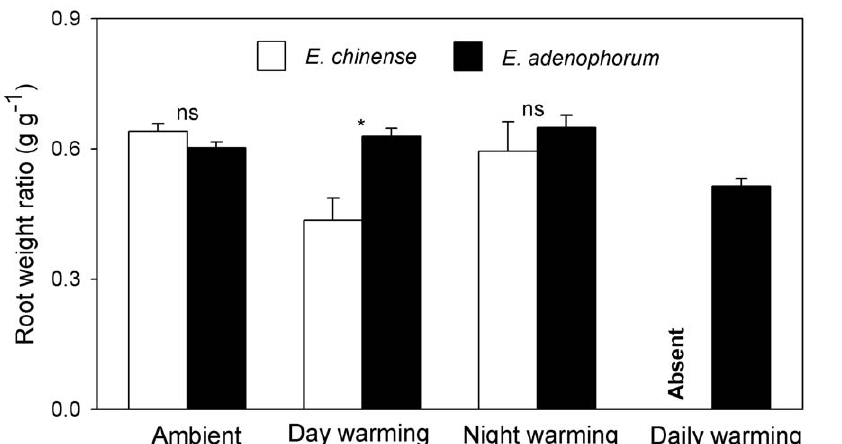
Figure 3. Root weight ratio of the invasive plant Eupatoriumadenophorum and the native plant Eupatoriumchinense grown in four different air temperatures. Data are means + 1 SE. ns=not significant; * P ,